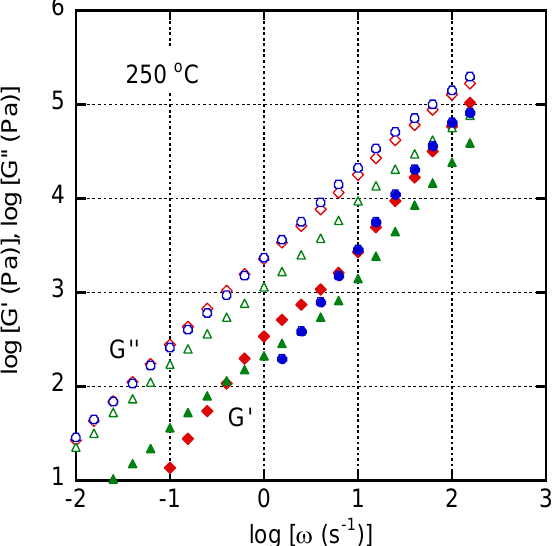
Figure 3. Angular frequency dependences of oscillatory shear moduli such as storage modulus G’ (closed symbols) and loss modulus G” (open symbols) at 250 °C for PC/LDPE (97/3) (circles), PC/LDPE (90/10) (diamonds), and PC/LDPE (75/25) (triangles).